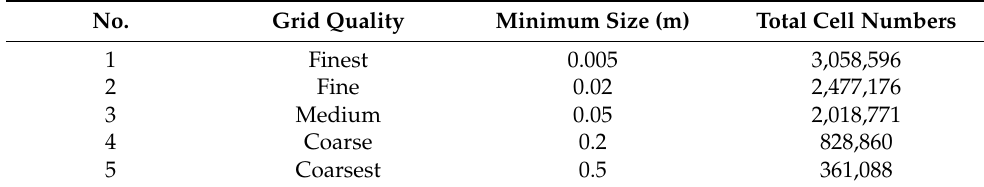
Table 5. Total cell numbers of five consecutive grids.